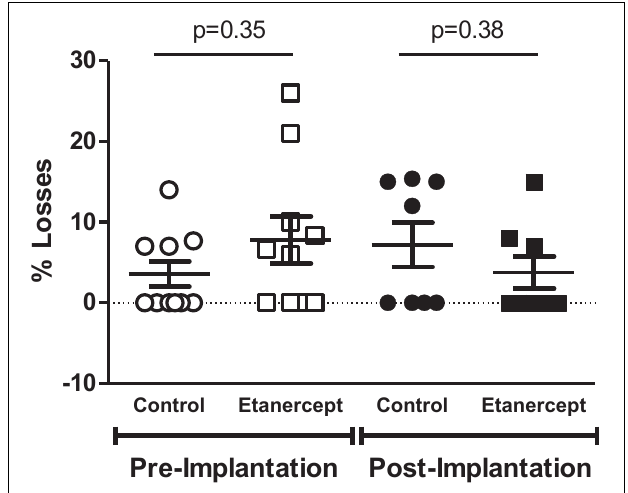
FIGURE 1 | Percentage of embryo losses before and after implantation, evaluated at term of pregnancy (DP21) of control and etanercept-treated rats. Pre-implantation losses of the control group (open circles, n = 10) and etanercept (open squares, n = 10). Post-implantation losses of the control group (dark circles bar, n = 10) and etanercept (dark squares, n = 10). Statistics was conducted using the Mann Whitney